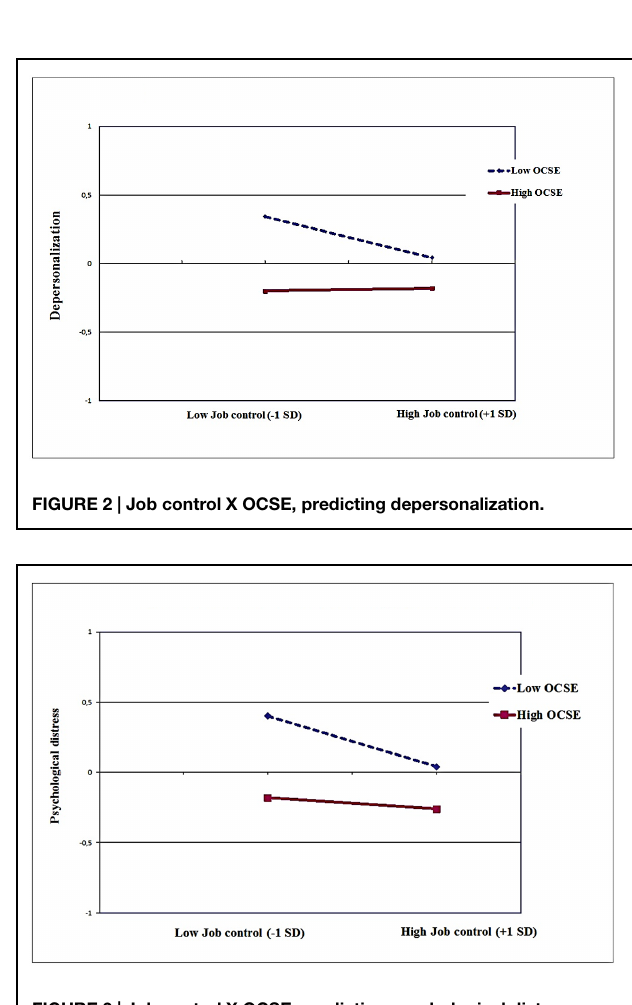
FIGURE 1 | Job control X OCSE, predicting emotional exhaustion.